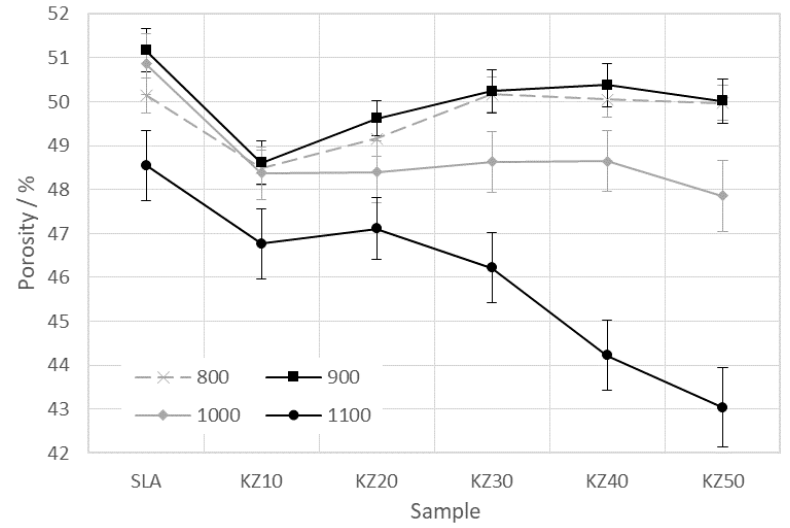
Figure 16. Porosity of the studied samples at 800, 900, 1000, and 1100 °C.